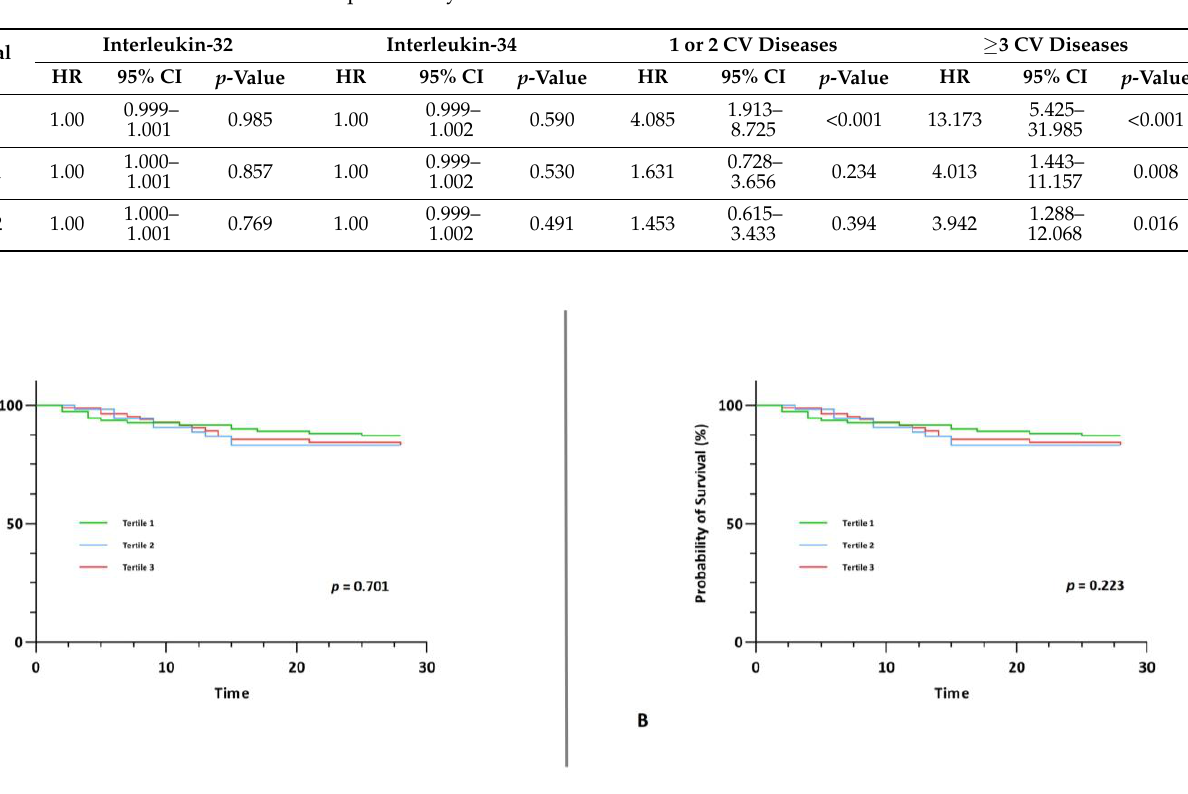
Figure 3. Kaplan-Meier survival curve for the primary endpoint of 28-day mortality stratified by tertiles of IL-32 ( A ) and by tertiles of IL-34 ( B ). Table 4. Association of interleukin-32, interleukin-34 and CV disease with the primary endpoint. The crude model only included the biomarker in question; Model 1 was adjusted for age and gender; Model 2 was adjusted for Model 1 and arterial hypertension, diabetes mellitus, chronic kidney dis- ease and chronic pulmonary disease.